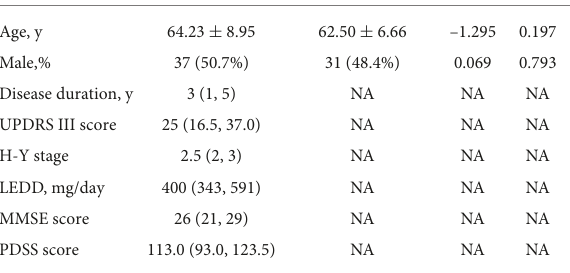
TABLE 1 Clinical characteristics and serum MMP3 and MMP9 levels of participants in individual groups in the current study. Characteristics PD ( n = 73) Controls ( n = 64) t / χ 2 P -value